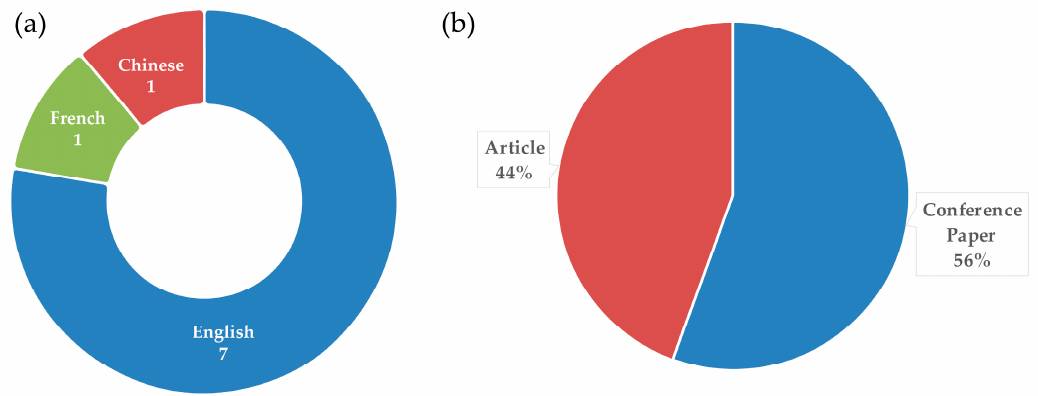
Figure 1. ( a ) Donut chart showing the distribution of the documents’ language. ( b ) Pie chart with the distribution of the documents’ type.